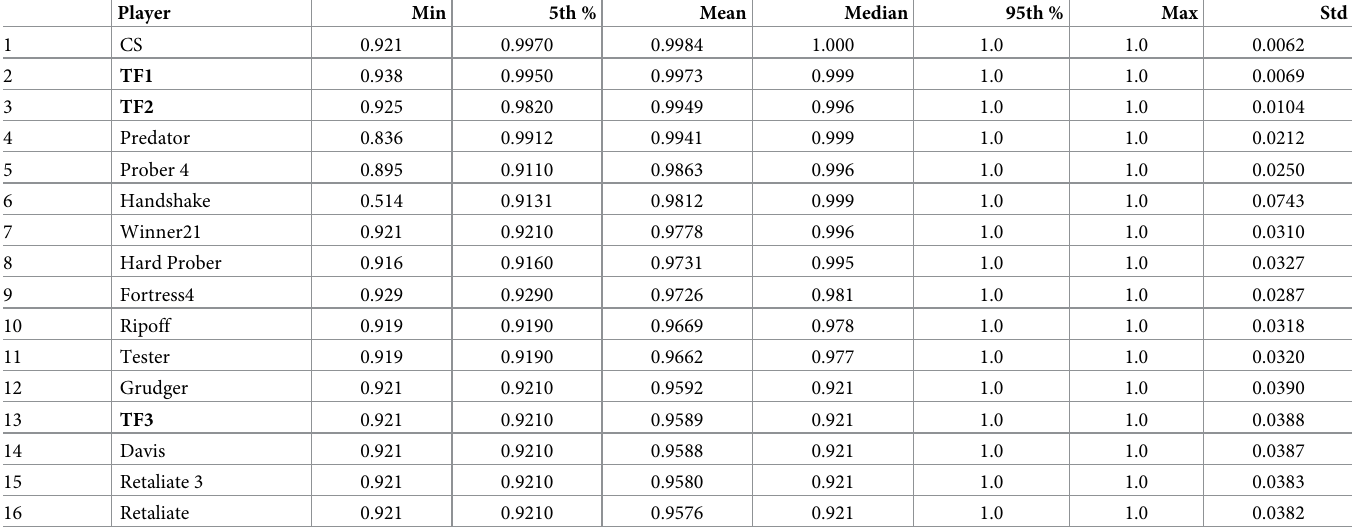
Table 10. Top resistors for N =